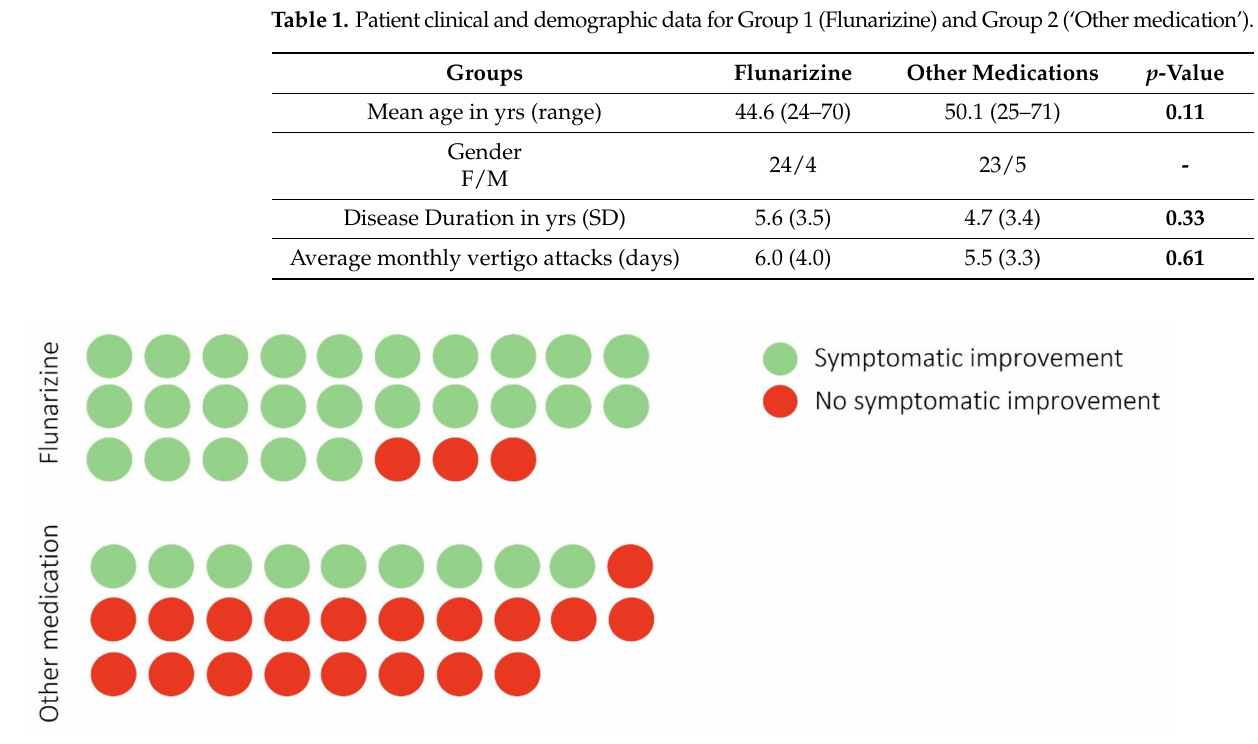
Figure 1. Symptomatic outcome with flunarizine versus ‘other medications’. Each circle represents a patient.